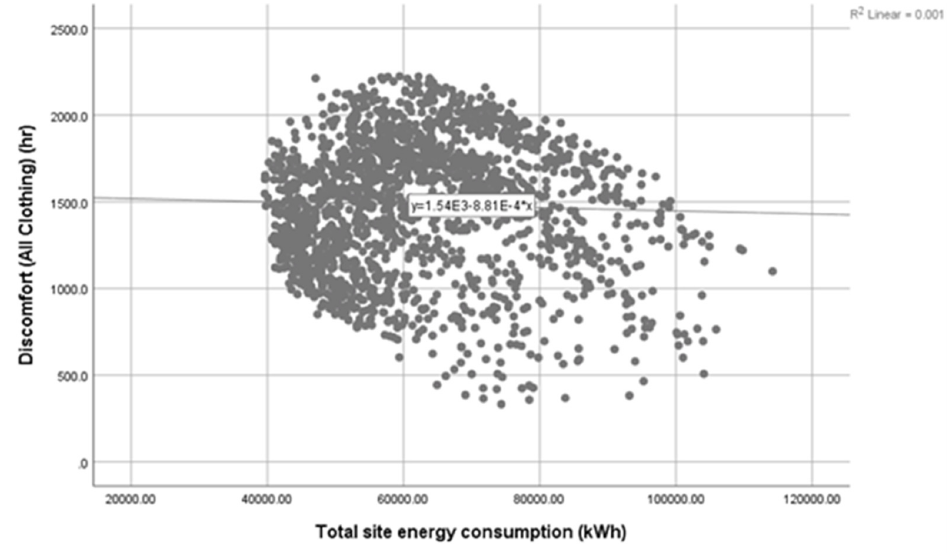
Figure 17. Correlation results. Table 4. Summary output of Pearson analysis .